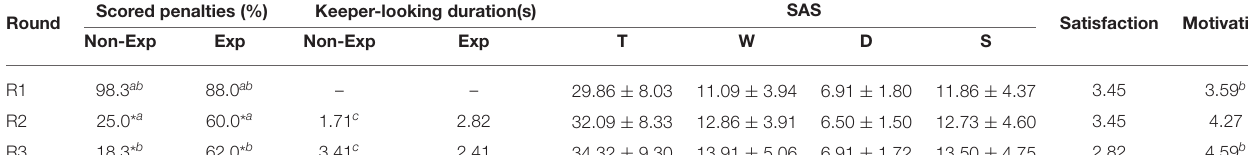
TABLE 1 | Behavioral results showing the percentage of the penalties that were scored for both experienced (Exp) and inexperienced (Inexp) players in each round, the averaged duration (out of the 5-s waiting period) that the players were looking at the goalkeeper, the average and standard deviation of the reported SAS scores enumerated by total (T), worry (T), disruption (D), and somatic (S) scores, satisfaction ratings and motivation ratings at the end of each round; * indicates significant difference between Exp and Inexp at p < 0.01 (corrected by Bonferroni correction); a, b, and c indicate significant differences at p < 0.05 (corrected by Bonferroni correction) between rounds 1–2, 1–3, and 2–3, respectively.